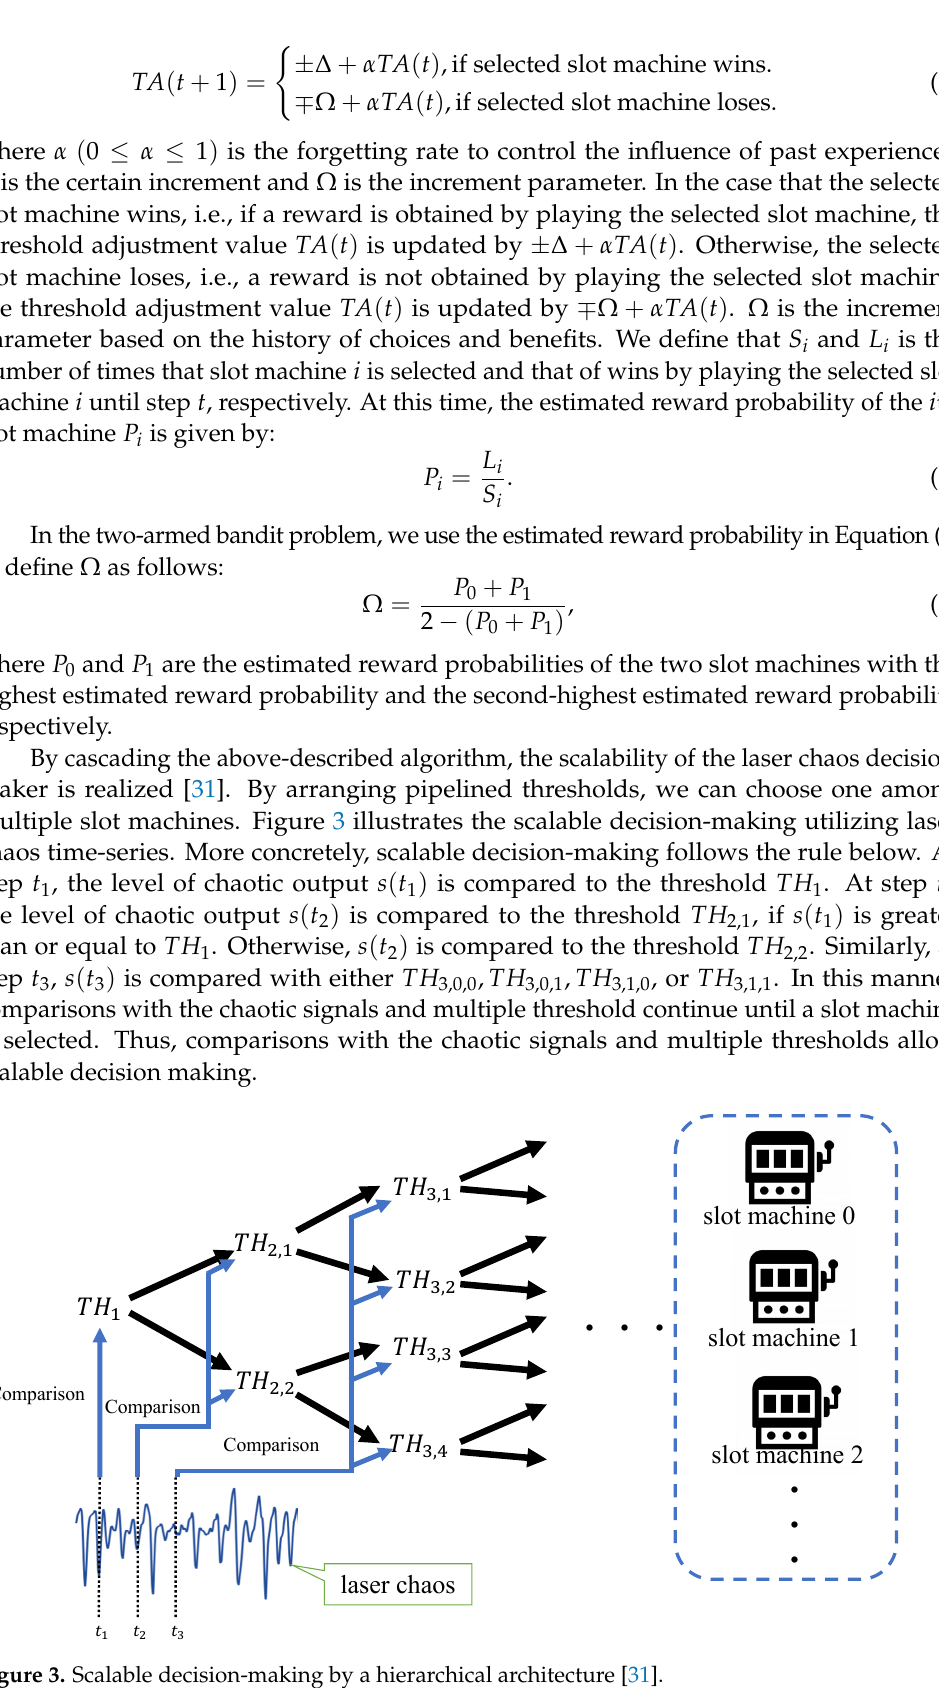
Figure 3. Scalable decision-making by a hierarchical architecture